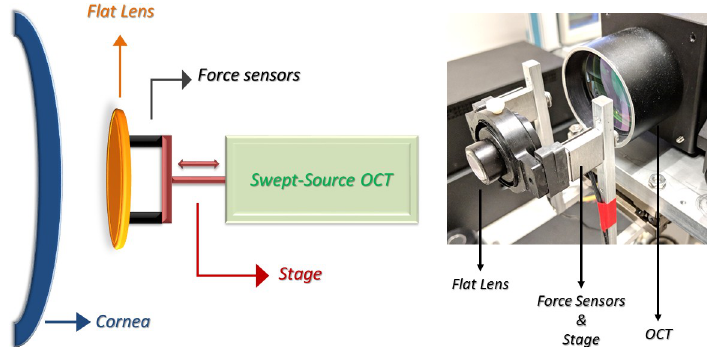
Fig 1. Left : OCT elastography system patient interface schematic diagram. Right : Photograph of the optical coherence elastography prototype highlighting the applanating apparatus (lens, force sensors and linear actuator stage).